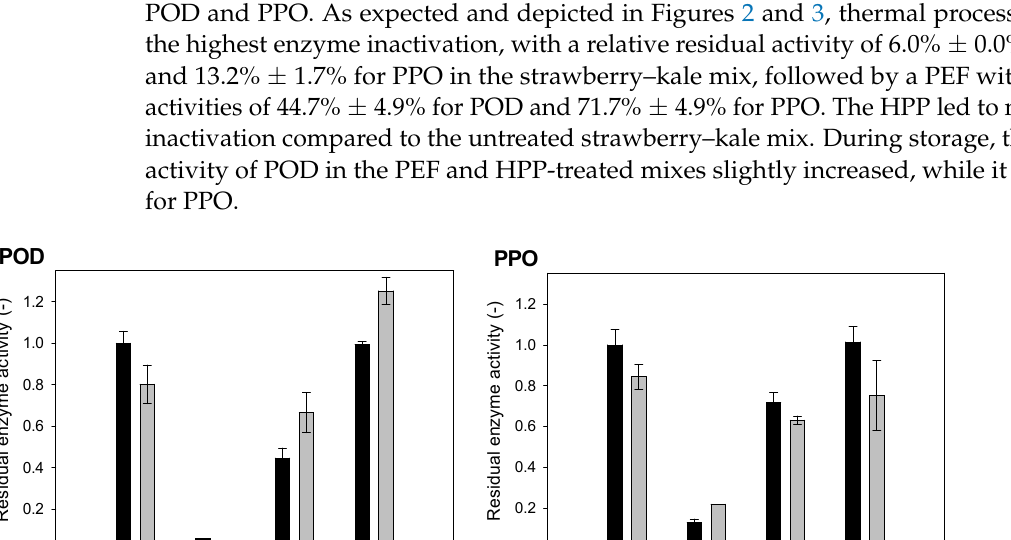
Figure 1. Total aerobic plate count (log CFU/mL) during refrigerated storage at 4 °C (n = 2). PEF: pulsed electric fields and HPP: high-pressure processing.